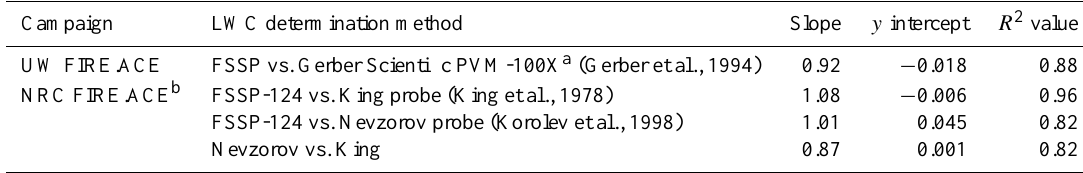
Table 5. Comparison of LWC measurements (gm − 3 ) from various instruments. Campaign LWC determination